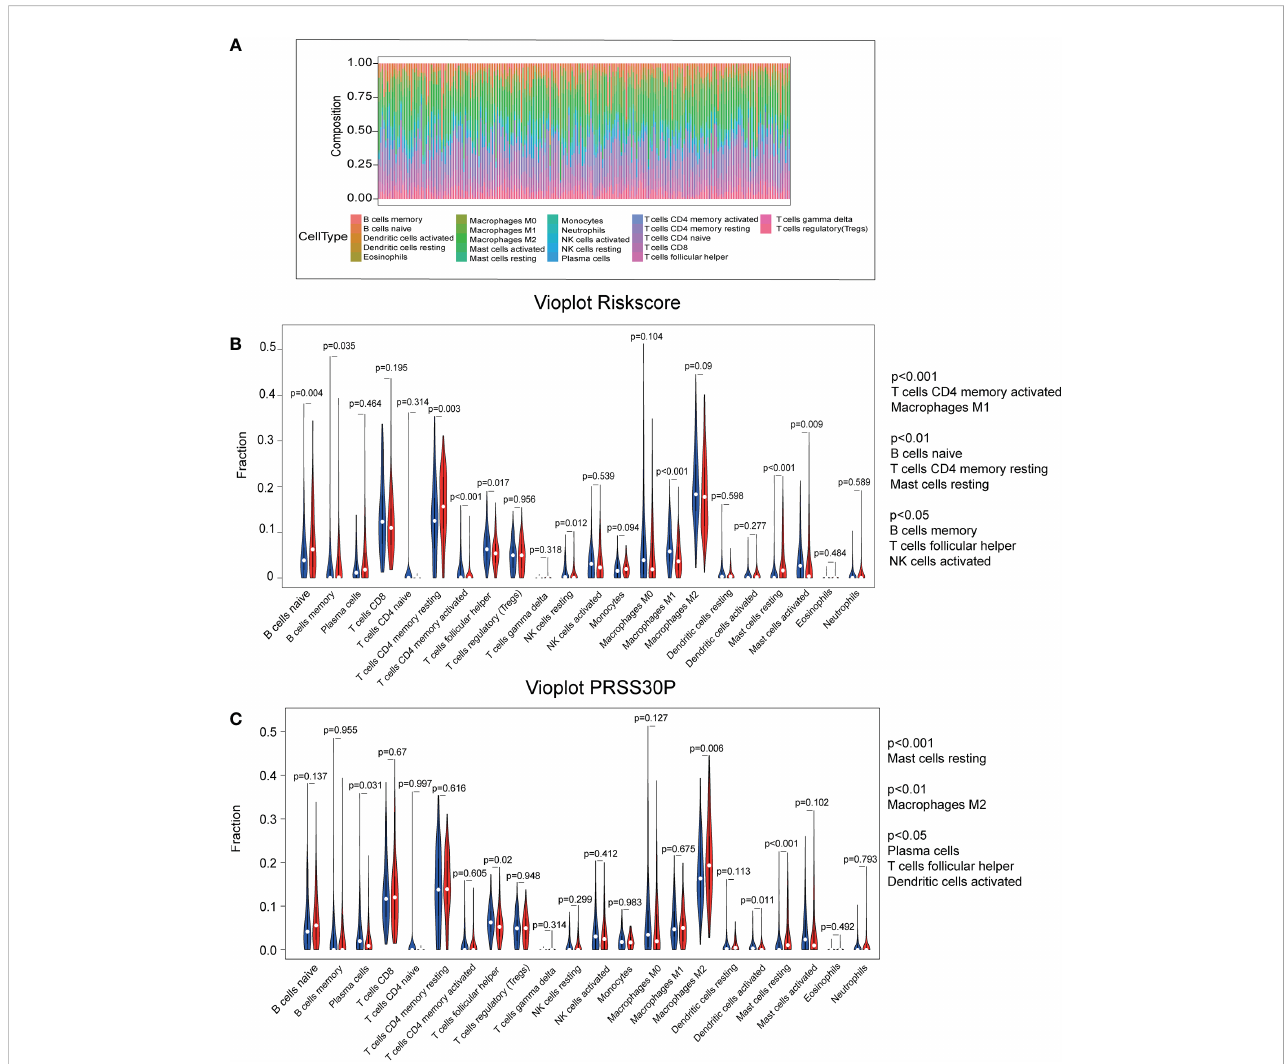
FIGURE 6 Immune in fi ltration using the CIBERSORT database. (A) The RNA-Seq of TCGA-STAD database was analyzed to obtain the abundance ratio matrix of 22 immune cells via CIBERSORT. (B) The differential abundance of immune in fi ltrates was obtained by comparing the distribution of immune cells in low- and high-score groups using R software. (C) The differential abundance of immune in fi ltrates was obtained by comparing the distribution of immune cells in low- and high-PRSS30P groups using R